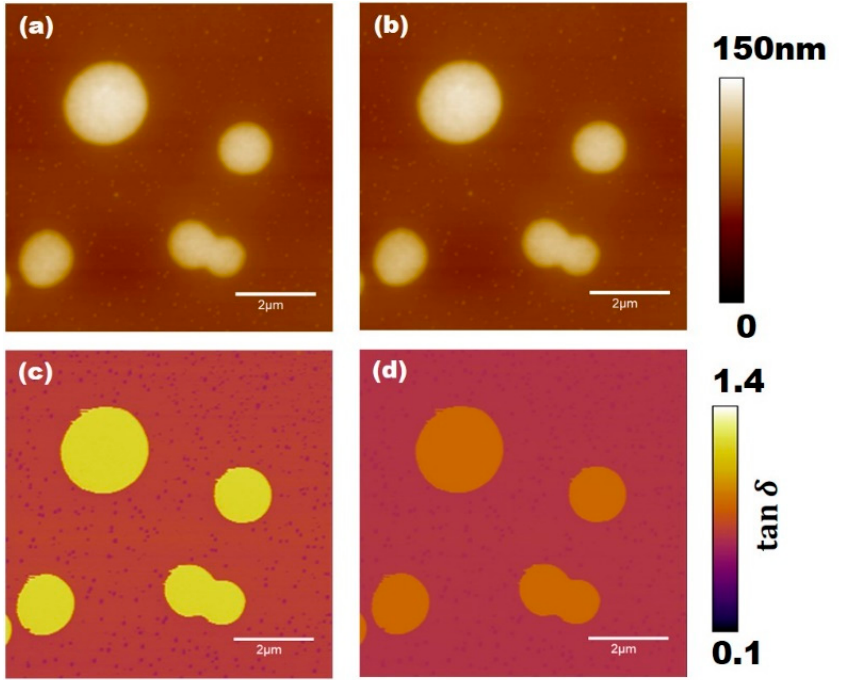
Figure 2. PS-LDPE loss tangent AFM study: ( a ) height image done by 1st eigenmode ( b ) height image done by 2nd eigenmode. ( c ) loss tangent image done by 1st eigenmode, and ( d ) loss tangent image done by 2nd eigenmode. Images are 6 µ m by 6 µ m. Free first amplitude amplitude was 100 nm. Free second amplitude was 20 nm. The setpoint for both of the measurements was 50% to ensure repulsive regime imaging. First eigenmode frequency was 70 kHz and second eigenmode frequency was 458 kHz.